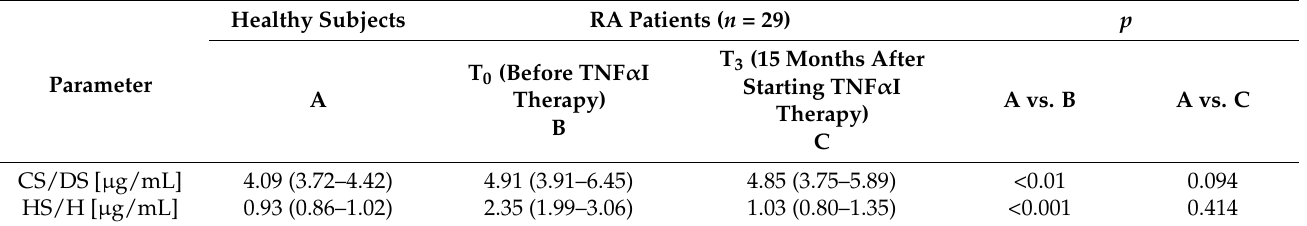
Figure 2. Changes to circulating levels of CS/DS ( a , b ) and HS/H ( c , d ) in all patients with rheumatoid arthritis (RA) during 15-month anti-TNF- α therapy and in groups divided by the type of treatment (ETA or ADA). a statistically significant differences compared to baseline; b statistically significant differences compared to 3 months after therapy; c statistically significant differences compared to 9 months after therapy. * p <0.05; ** p <0.01; *** p <0.001. ADA, adalimumab; CS/DS, chondroitin/dermatan sulfate; ETA, etanercept; HS/H, heparan sulfate/heparin; anti-TNF- α , anti-tumor necrosis factor- α . Table 2. Circulating levels of chondroitin/dermatan sulfate (CS/DS) and heparan sulfate/heparin (HS/H) in healthy subjects and patients with rheumatoid arthritis (RA) before and after 15-month anti-TNF- α